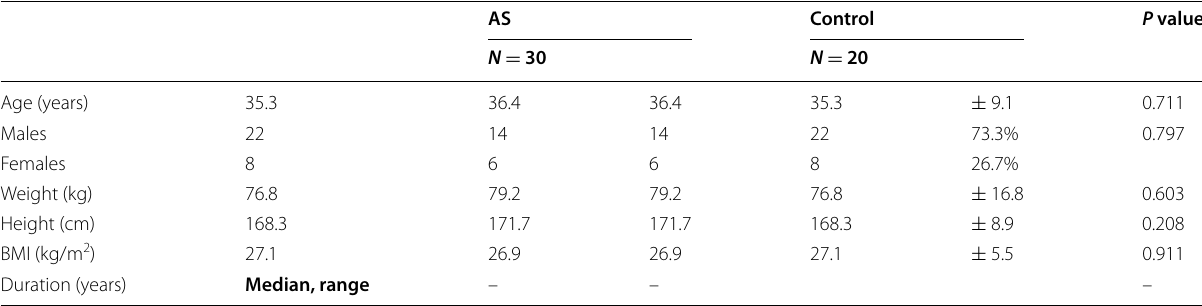
Table 1 Comparison of demographic and anthropometric data between the studied groups